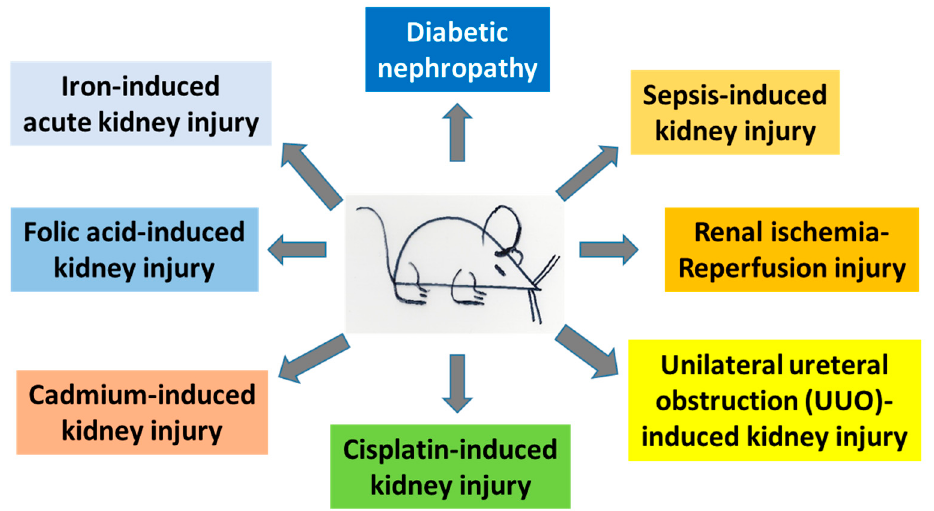
Figure 1. Animal models of kidney injury discussed in this article. These models include both acute kidney injury and chronic kidney